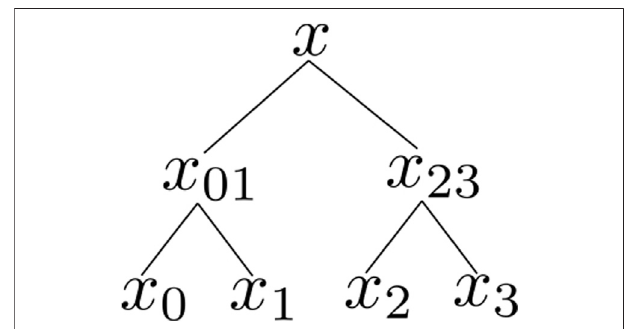
FIGURE 1 | Schematic representation of the Divide-and-Conquer algorithm for loading a four-dimensional vector x into a quantum state. The task of preparing | x 〉 is divided into subtasks and can be represented as the logic tree shown above. Adapted from